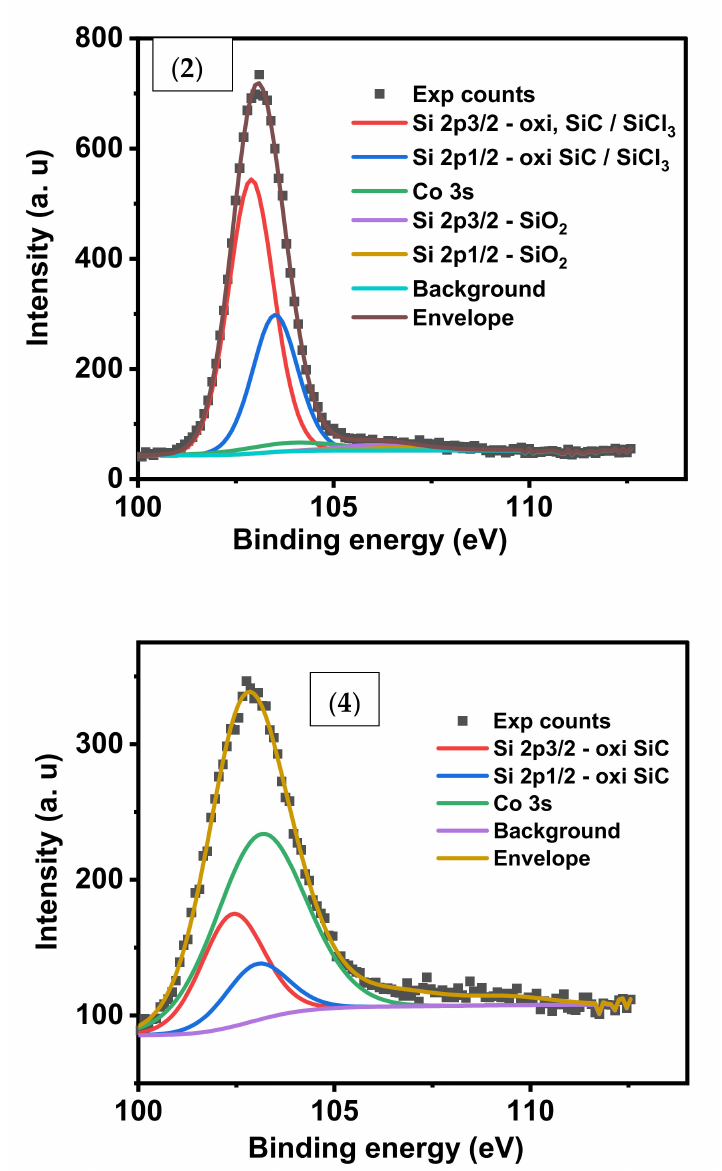
Figure 5. XPS convolution Si2p-Co3s spectrum for the three samples (1), (2) and (4). The O1s XPS convolution spectrum (Supplementary Figure S5) revealed that the main peak refers to O=C species more than oxidized SiC and carbonates. This peak is highest for sample (2) with 82.47% contribution to total oxygen. The XPS C1s convolution spectra for the three samples (1), (2) and (4) were shown in Figure 6. The oxidized SiC species in sample (2) represent 52.39%, the highest percentage contribution of carbon species among the samples. C-C/C-H carbon constitutes 62.7% in (4) which indicates efficient adsorption of CV by sample (1). The amine/amide contribution is 59.1% in the N1s spectrum of (1) and 58.87% for (2). It increased to 76.69% for (4) due to the presence of adsorbed CV dye which contains amine groups, Figure 7. Moreover, Co-N constitutes 25.23% in the N1s spectrum of (2) reflecting that cobalt nitride species is formed during thermal treatment of cobalt